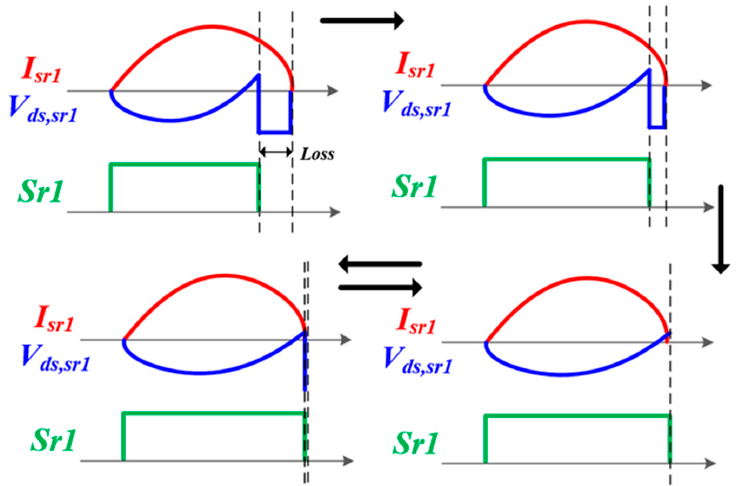
Figure 10. Operating waveforms of synchronous rectification shown in [38].